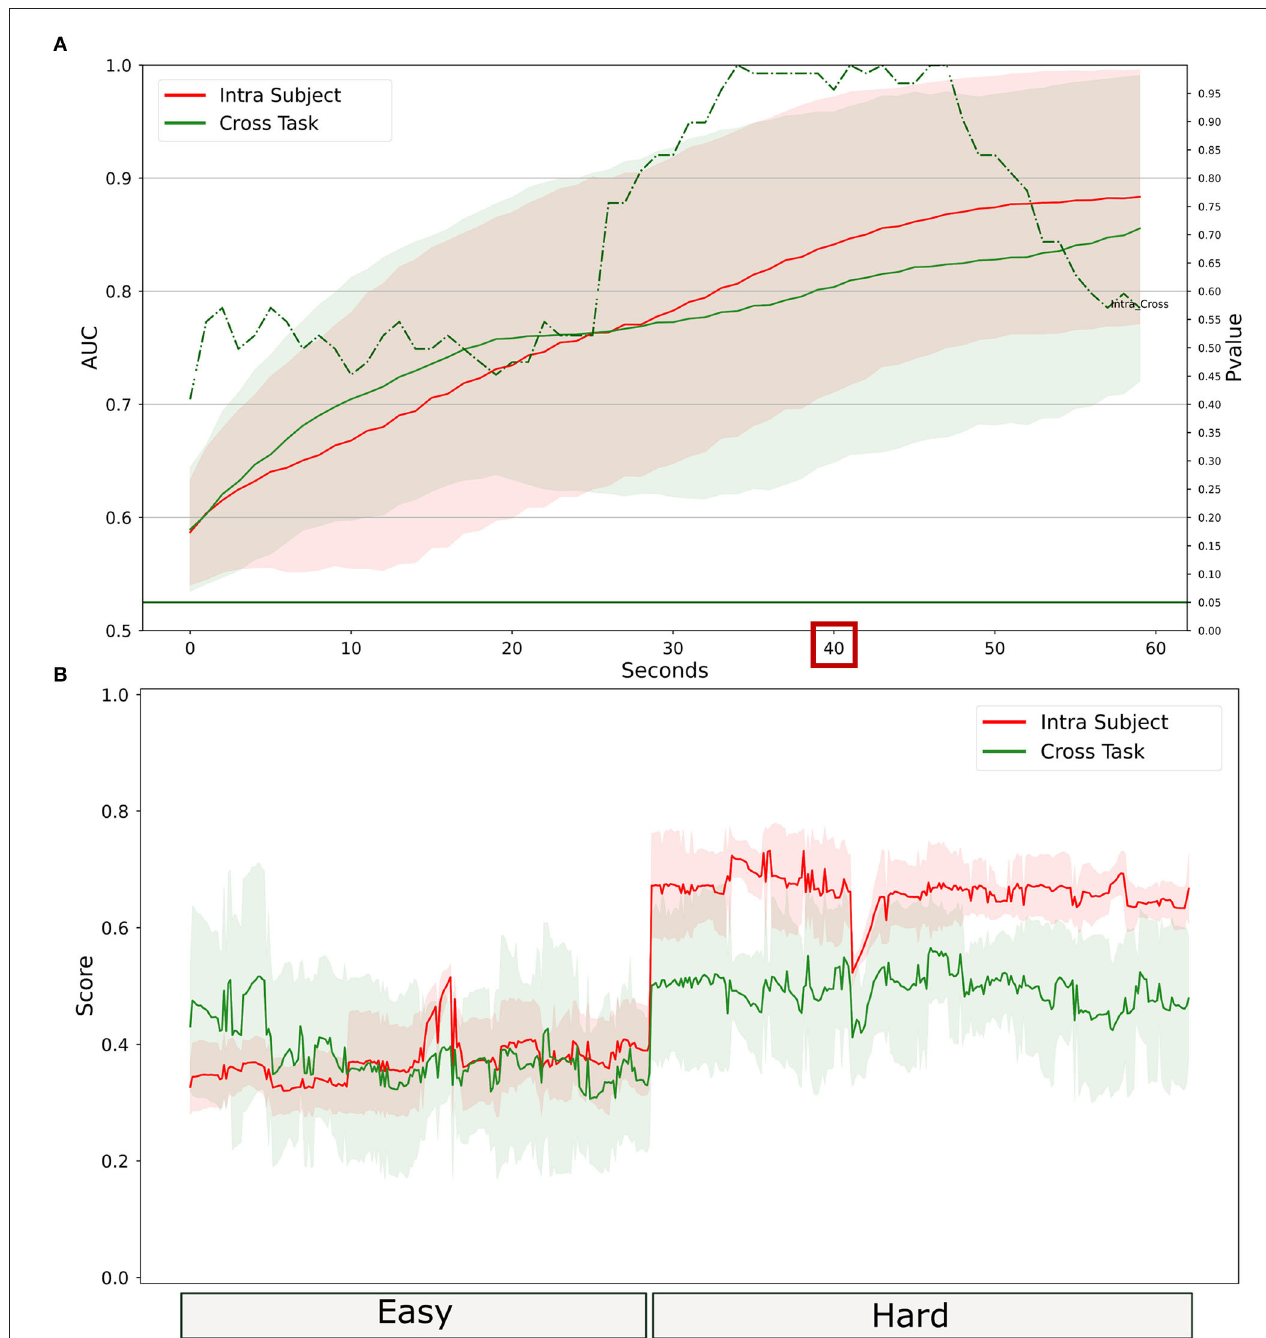
FIGURE 10 | Comparison between intra-subject and cross-task calibration for workload discrimination in a realistic setting. (A) AUC values obtained by water electrodes through intra-subject (red) and cross-subject (green) calibration for different time resolutions (1–60s). The solid lines represent the median of the AUC among the participants. The shadows represent the mean absolute deviation of the AUC across participants. The dashed green line represents the results in terms of p -values of the Wilcoxon signed-rank test. The threshold of significance ( p = 0.05) has been highlighted in the same color. (B) The workload index obtained from each of the two models at 40s of temporal resolution. The line represents the average over the population, the shadow represents the standard deviation. beginning and the end of each experimental condition.